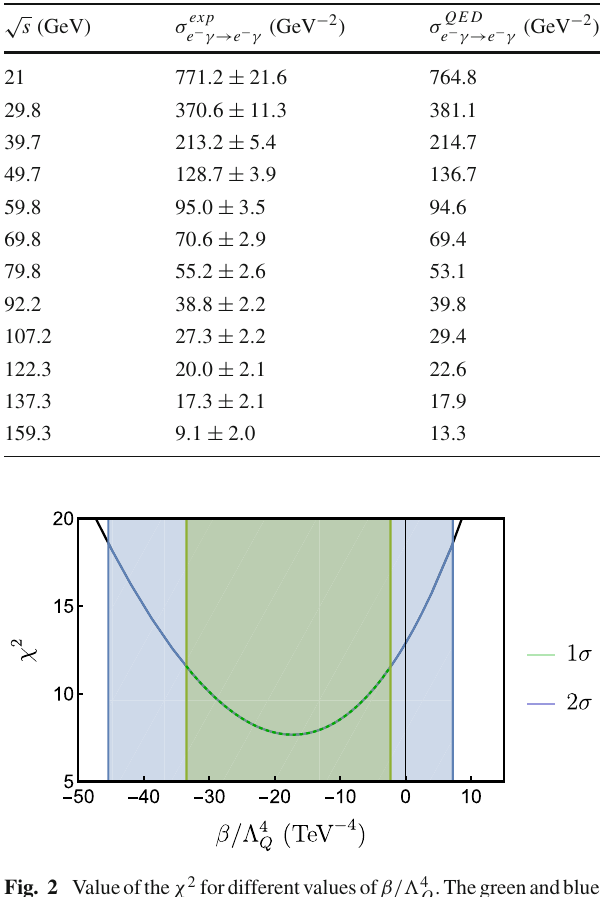
.Thegreenandblue Q at 1 σ and 2 σ probability, Q